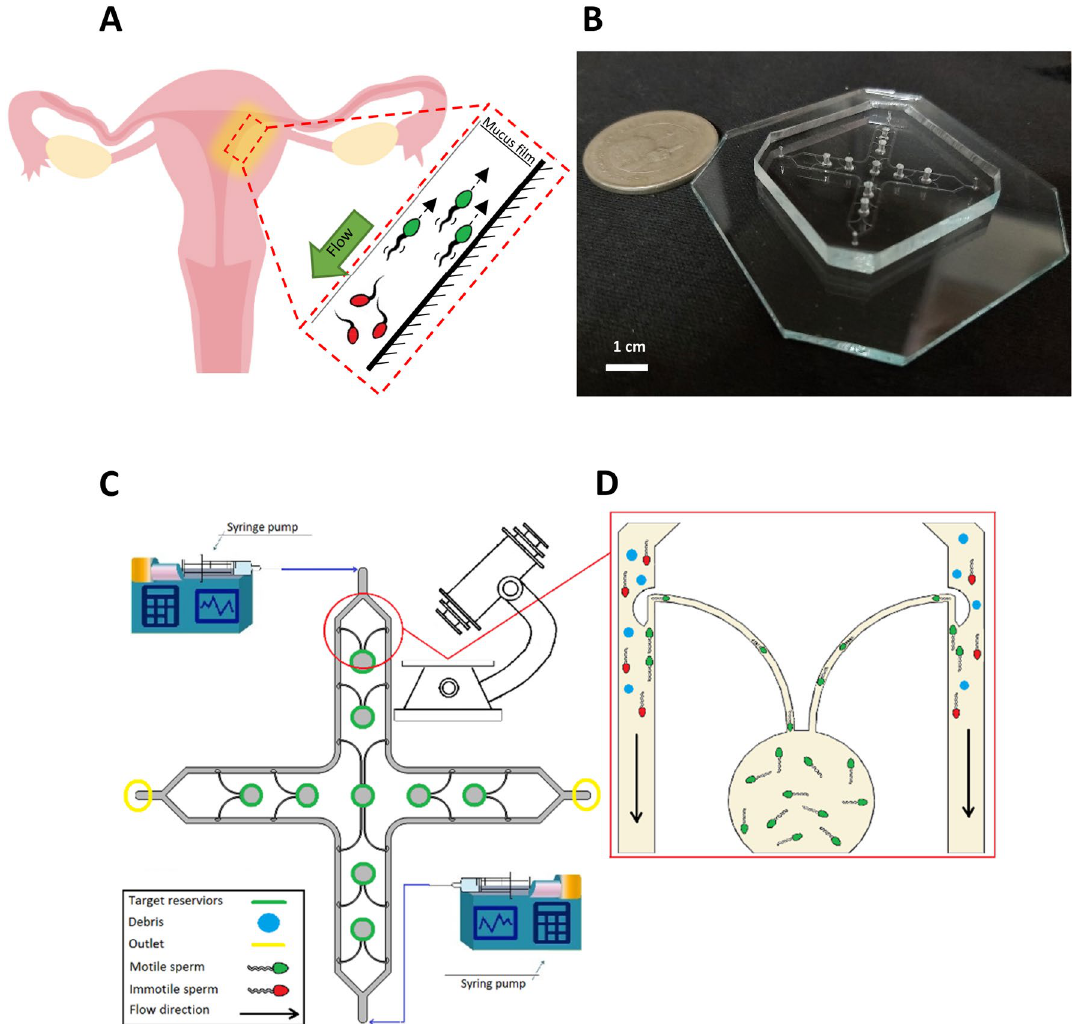
Figure 1. Microfluidic device for sperm separation. ( A ) Basics of sperm separation mechanisms inside the female reproductive tract. Mucus flow over the uterus walls will wash the immotile sperm cells away (shown in red). In contrast, motile sperm cells (shown in green) will employ rheotaxis and boundary-following behavior to swim against the flow direction and move toward the oocyte. ( B ) The microfluidic device. ( C ) Mechanism of sperm separation in the proposed microchip inspired from the uterus walls. The obstacles placed along the walls create a rheotaxis zone in their frontal area and facilitate the entrance of healthy sperm into the narrow curved channels. Then by employing the boundary-following behavior, sperm cells are guided to reach the target reservoirs. ( D ) Schematics of the proposed device’s performance. Part A was generated using Edrawmax 43